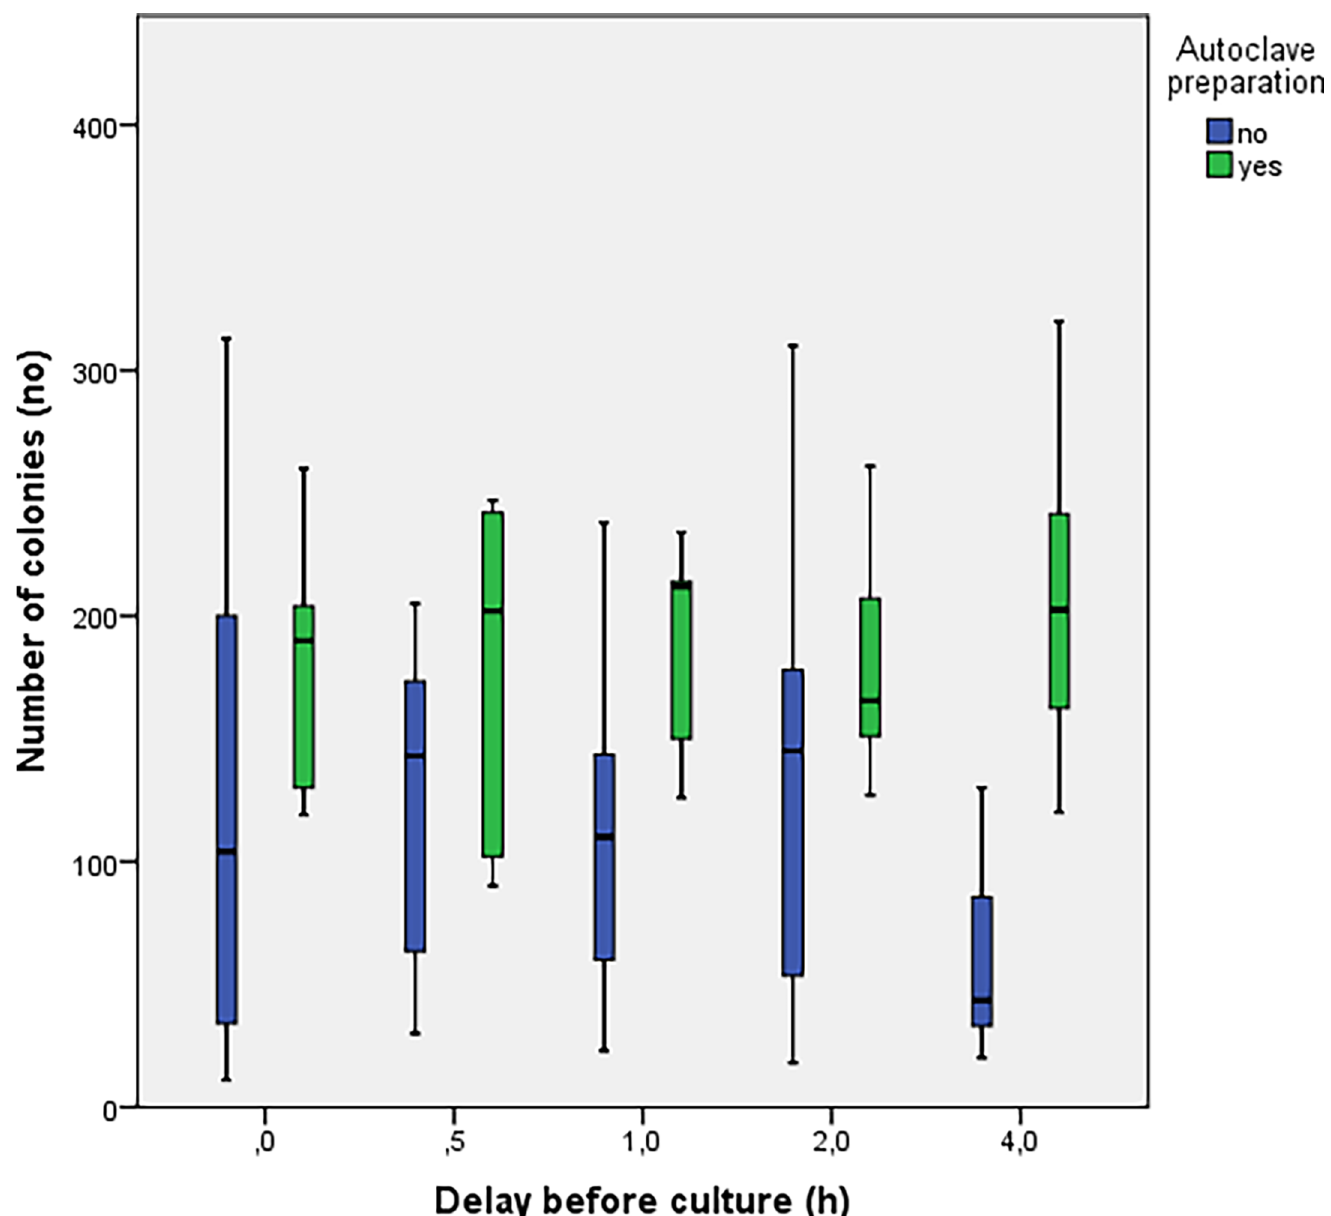
Fig 4. Results for the 3rd experiment. In green the bone preparation with autoclave and in blue without autoclave.